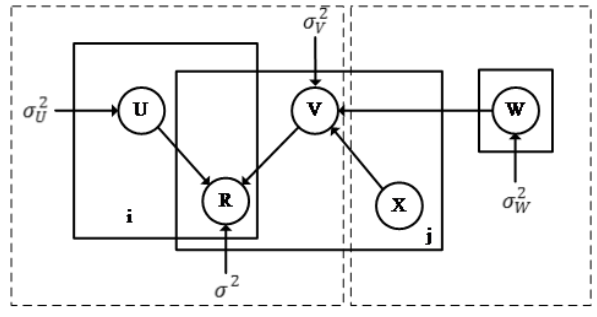
Fig. 2 Convolutional matrix factorisation model.